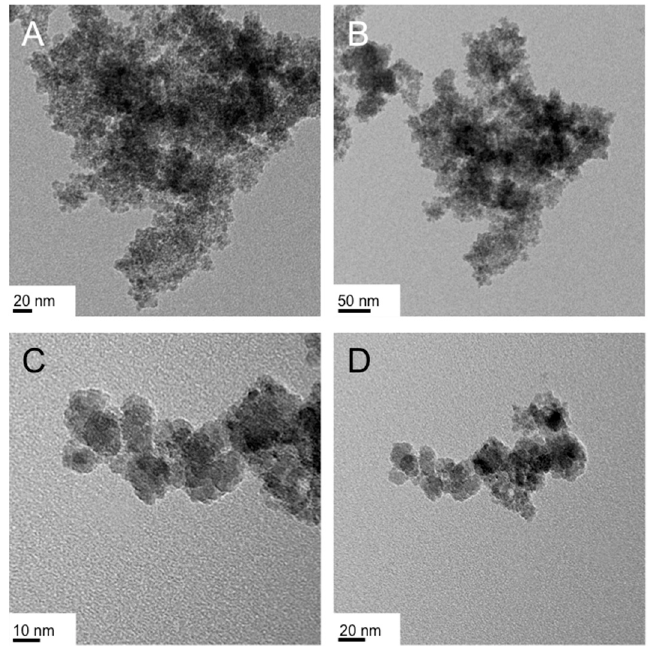
Figure 11. TEM images of the IO nanostructures obtained from the reduction/hydrolysis reaction of Fe(acac) 3 in the isotropic micellar liquid (rod-like micelles) formed by CTAB (20 wt %) in water at 60 °C: ( A , B ) froth fraction and ( C , D ) gel fraction.